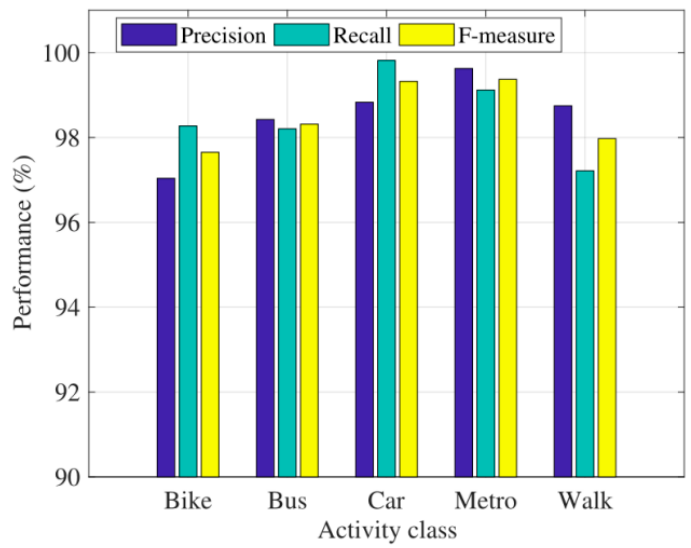
Figure 8. The performance of the proposed method.